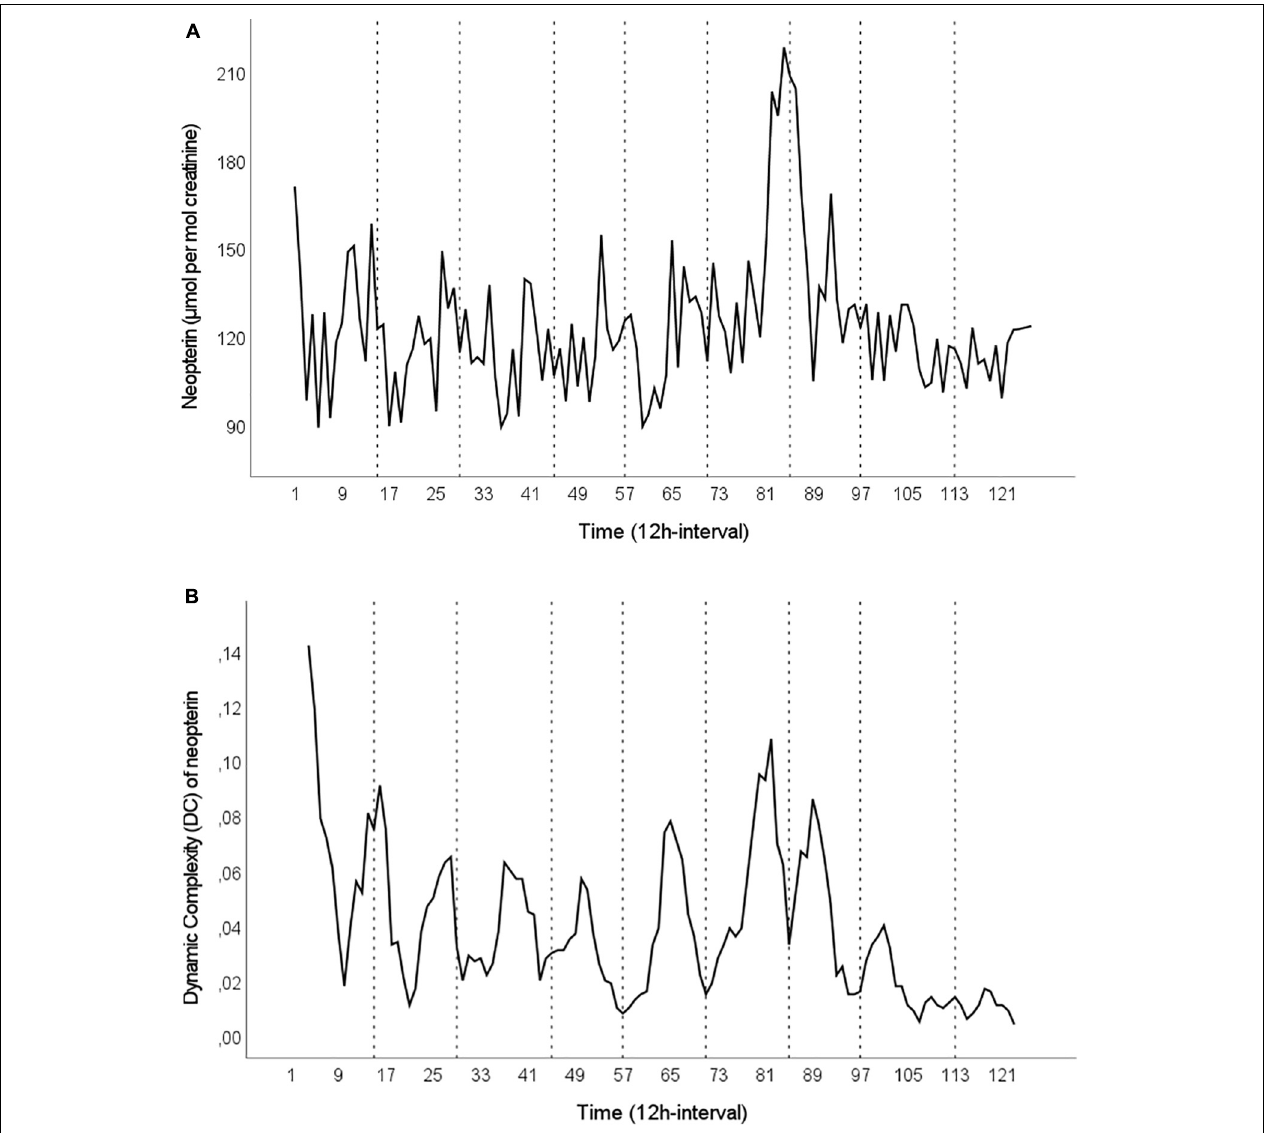
FIGURE 1 | (A) Time series of urinary neopterin in µ mol per mol creatinine over a period of 63 days in 12-h intervals ( n = 126). The data were collected in daytime intervals (8 a.m.–8 p.m., odd numbers) and nighttime intervals (8 p.m.–8 a.m., even numbers). (B) The Dynamic Complexity (DC) of neopterin over the course of the study in moving windows of seven 12-h intervals ( n = 120). In both figures, dotted vertical lines represent the time points of